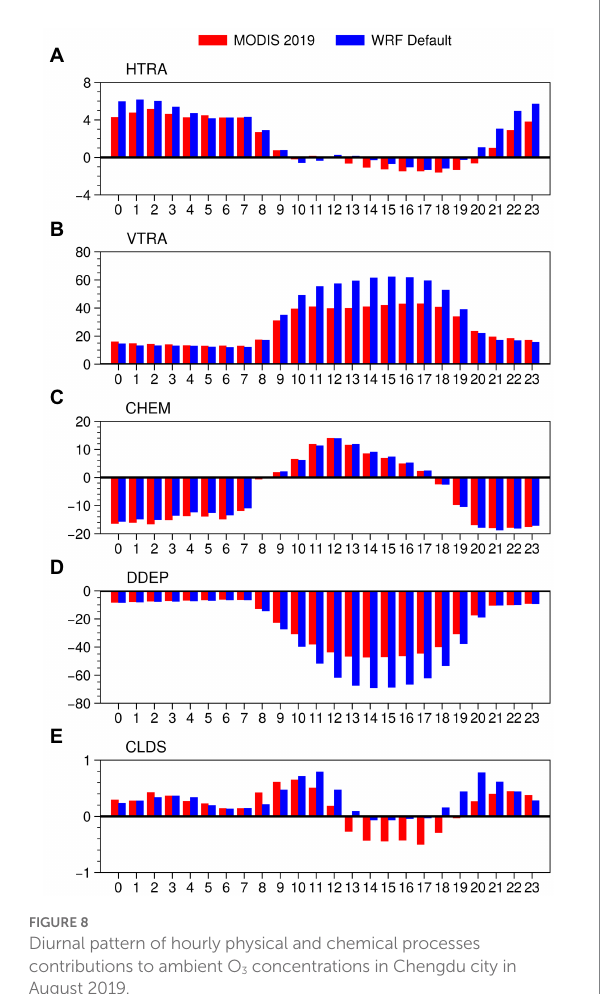
FIGURE 8 Diurnal pattern of hourly physical and chemical processes contributions to ambient O 3 concentrations in Chengdu city in August 2019.